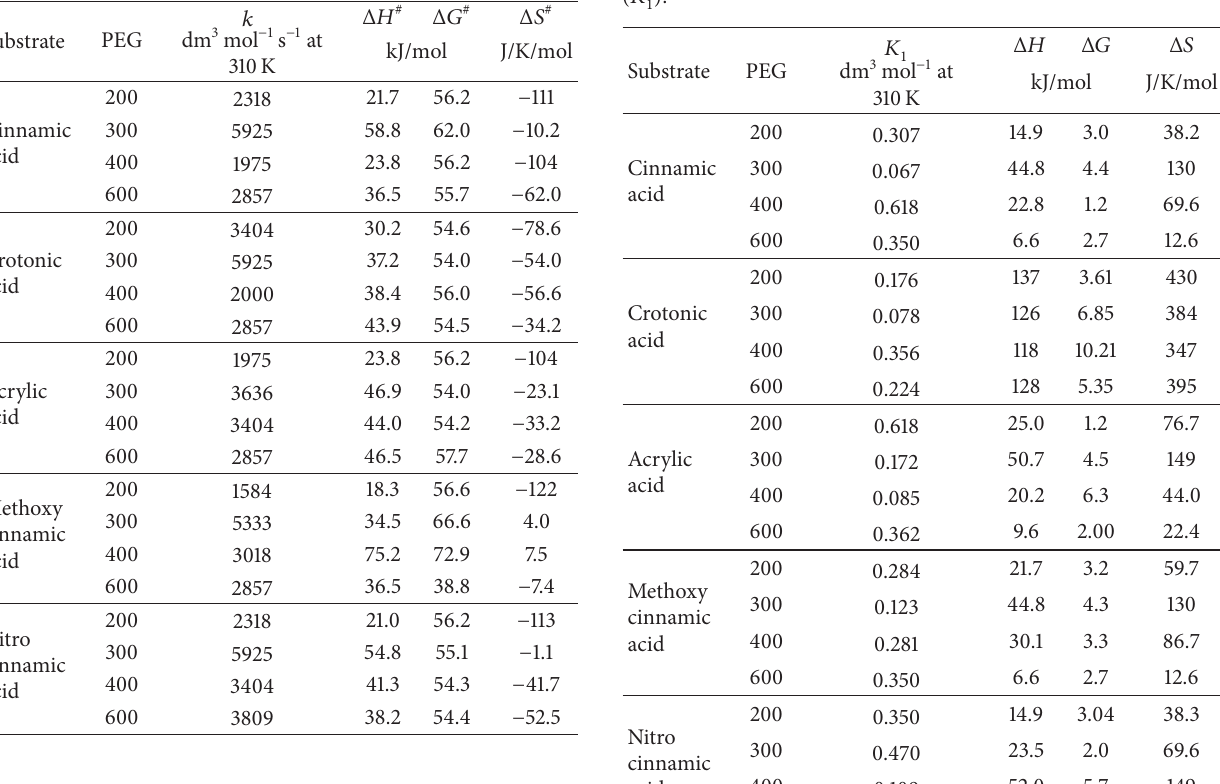
Table 3: Activation parameters involving rate constant (𝑘) . Table 4: Thermodynamic parameters involving formation constant